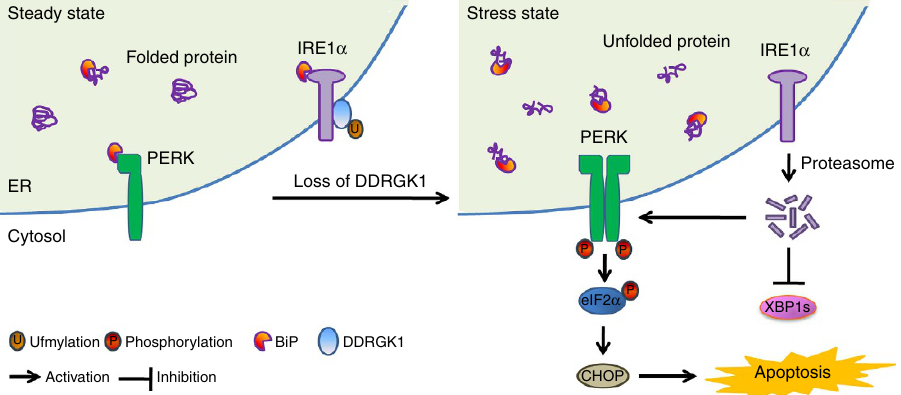
Figure 9 | Regulatory functions of DDRGK1 in the maintenance of ER homoeostasis. IRE1 a is stabilized through a physical interaction with DDRGK1 under homeostatic conditions. The loss of DDRGK1 decreases the protein abundance of IRE1 a and activates the PERK-eIF2 a -CHOP apoptotic